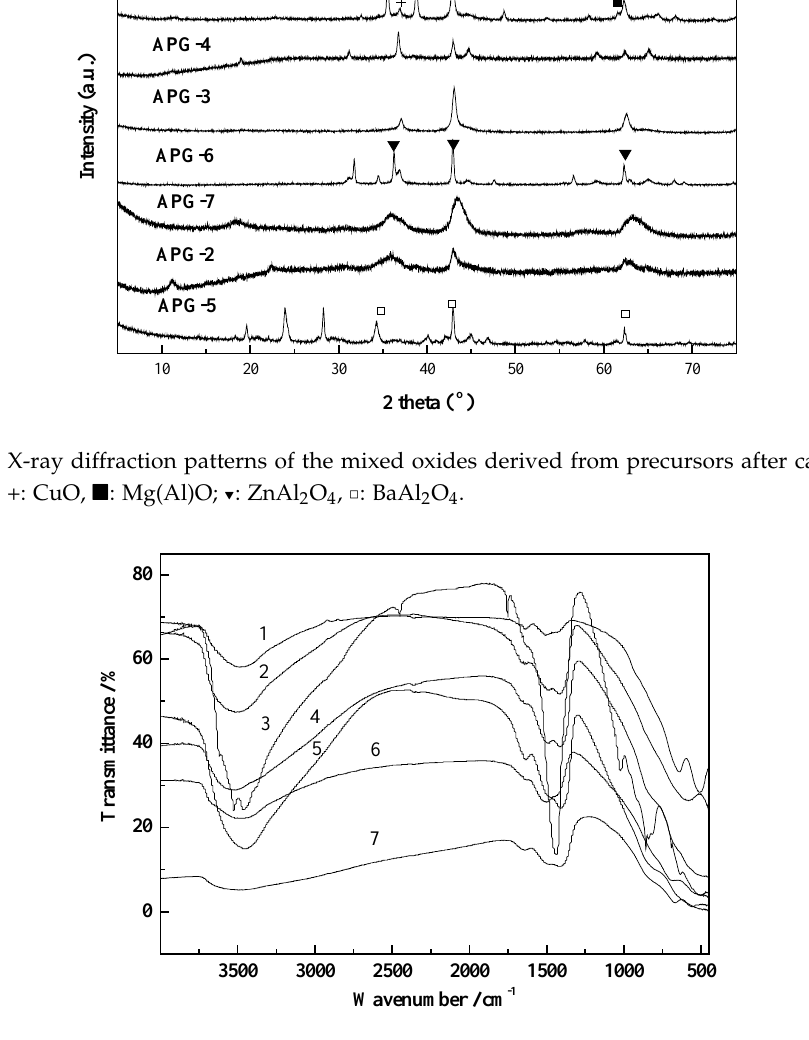
Figure 3. FT-IR spectra of the mixed oxides derived from precursors after calcinating at 700 ˝ C. 1: APG-7; 2: APG-2; 3: APG-5; 4: APG-1; 5: APG-3; 6: APG-6; 7: